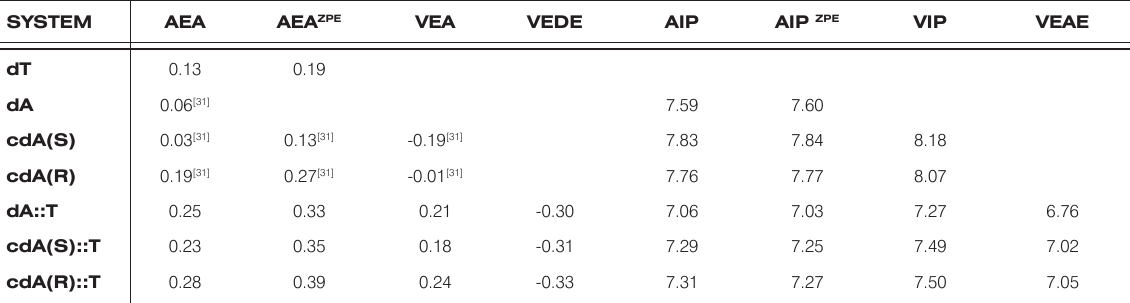
Table 2. The dispersion of negative charge led to